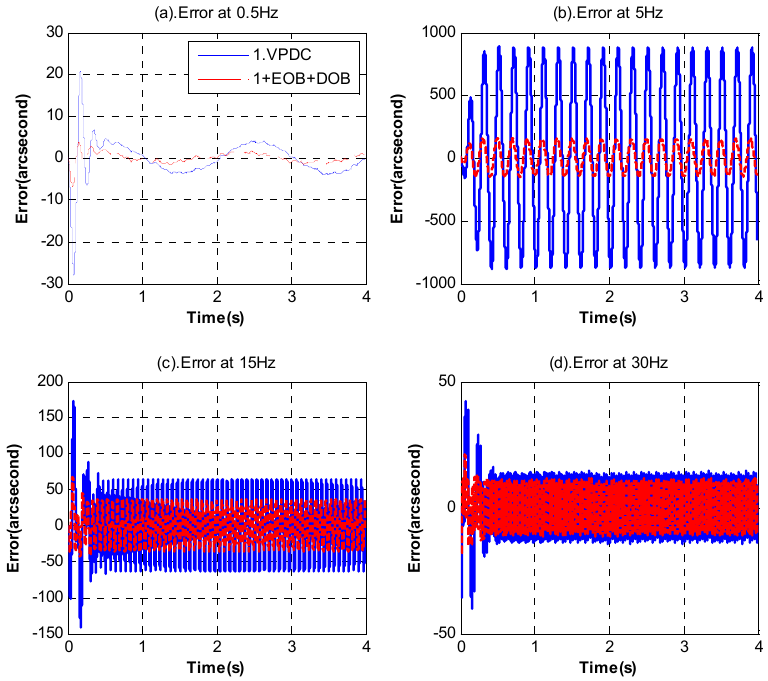
Figure 16. The residual stabilization errors in different frequencies.